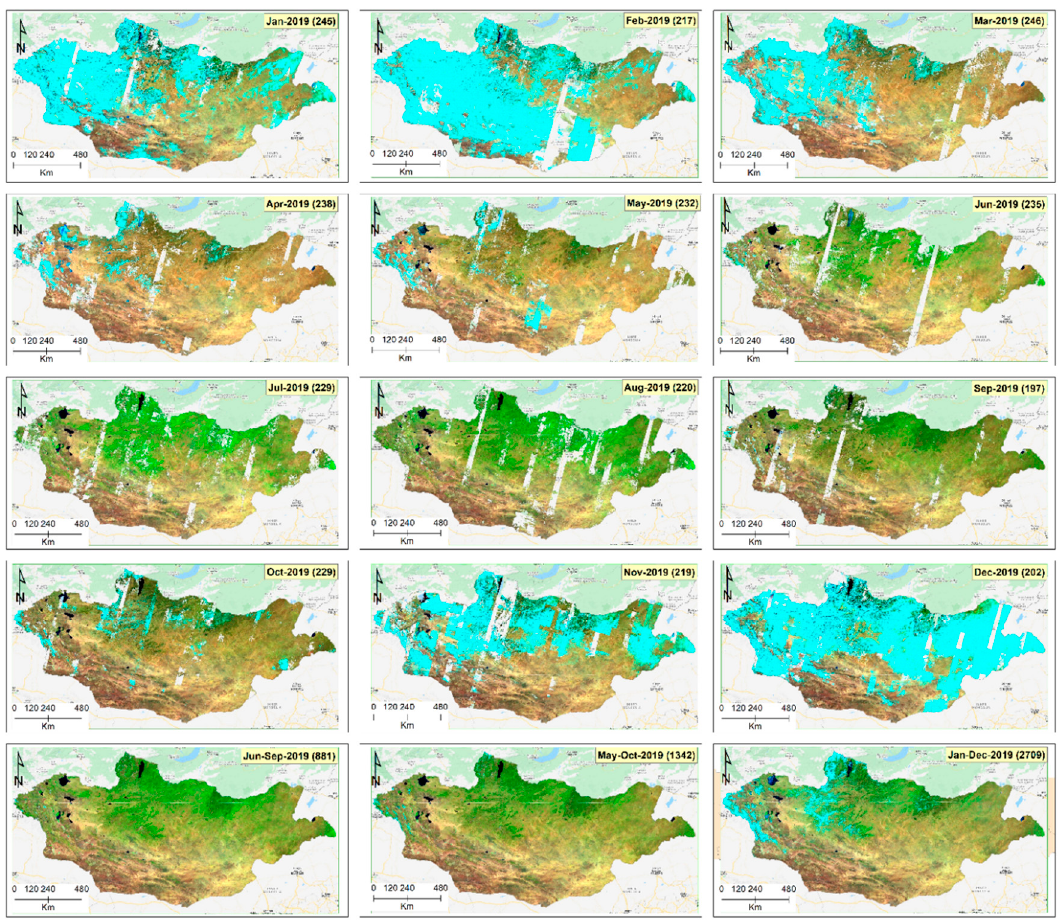
Figure 1. Monthly median natural composite (7-5-3) of Landsat 8 surface reflectance data over Mongolia in 2019. The number of Landsat scenes used for the composition is shown in parentheses. Bright blue represents snow cover.